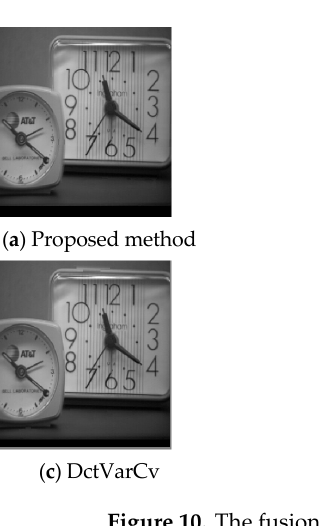
Figure 9. The fusion result of the aircraft image. Appl. Sci. 2019 , 9 , x FOR PEER REVIEW